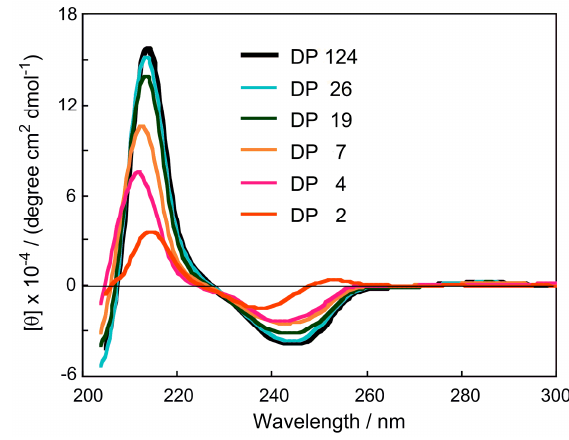
Figure 3. CD spectra of CDMPC-2, 4, 7, 19, 26 and 124 in THF.